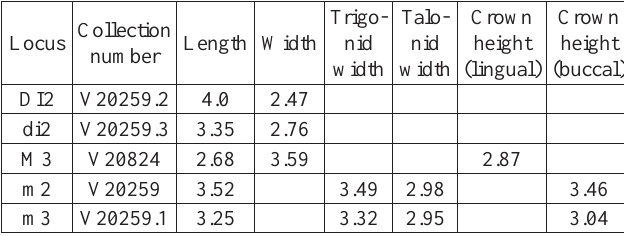
Table 2. Measurements (in mm) of Gomphos progressus